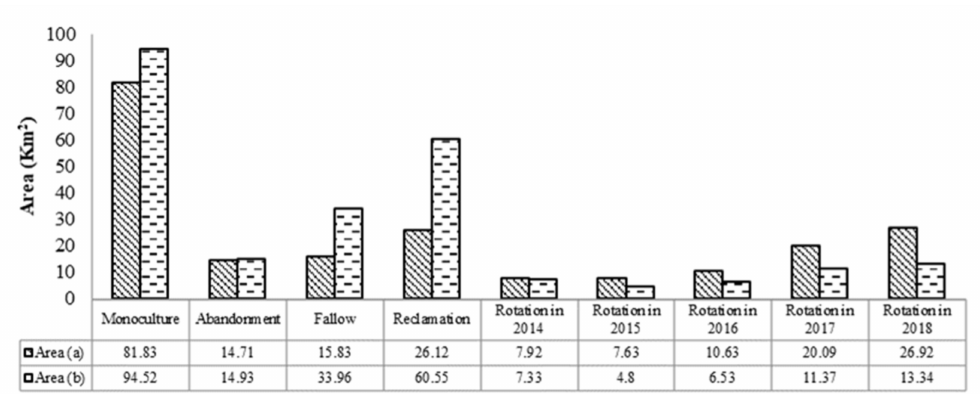
Figure 9. Area of multi-year cotton-cropping patterns from 2014 to 2018; ( a ) pixel-based multi-year cotton cropping pattern, ( b ) GIS-driven multi-year cotton cropping